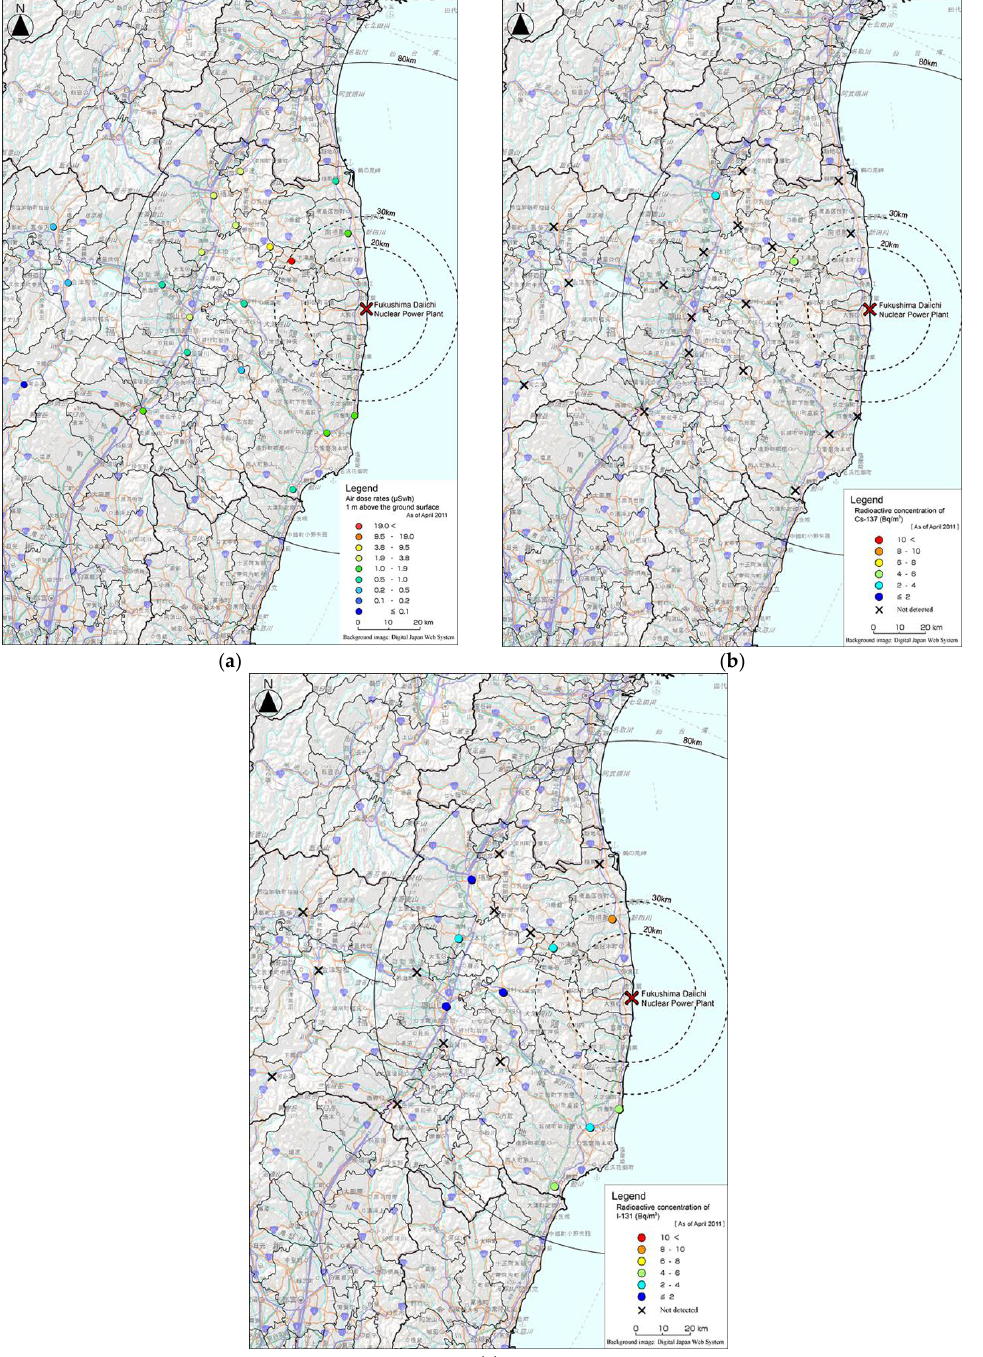
Figure 5. Local dose rates (in µSv/h) ( a ) and activity concentration of radio nuclides Caesium-137 ( b ) and Iodine-131 (in Bq/m 3 ) ( c ) in school grounds in Fukushima Prefecture in April 2011 [64].